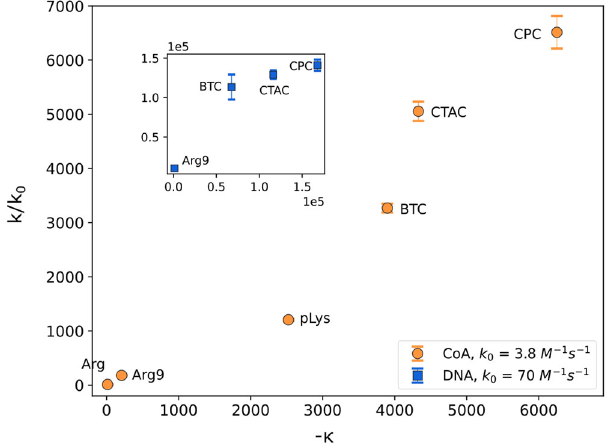
Fig. 6 | Theoretical model. Reactionrate increases asafunction of − κ forCoAand DNA. The values of k 0 are obtained from the fi t of the linear function k = − k 0 κ to experimental data for each reactants. Error bars correspond to weighted mean errors calculated as described in Supplementary Note 3. Source data are provided as a Source Data fi